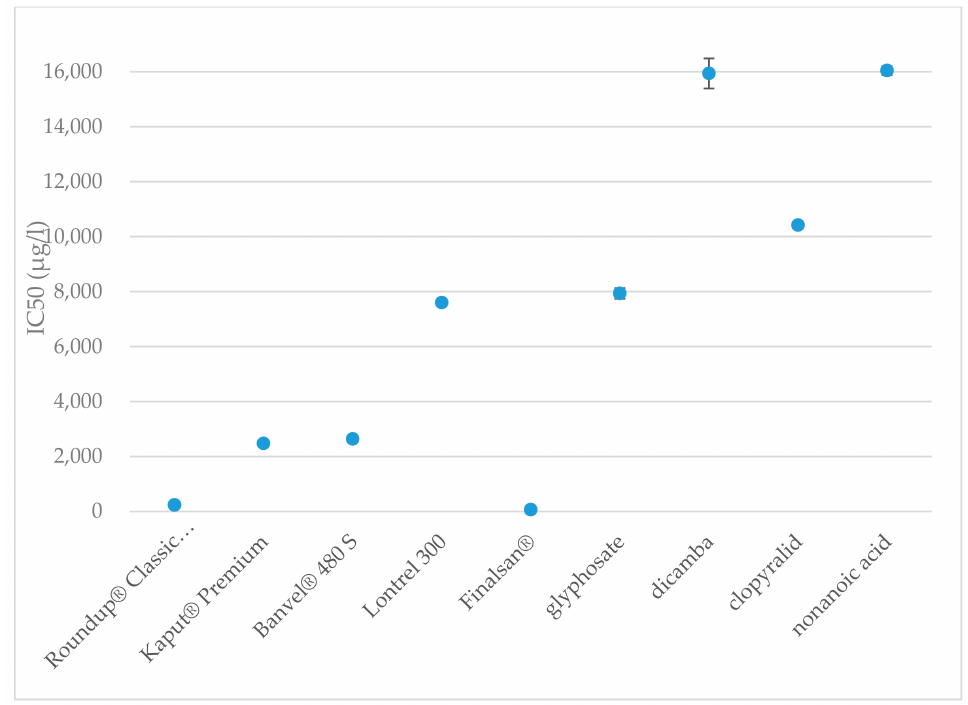
Figure 1. Toxicities of the herbicides and active substances after 15 min of exposure to A. fischeri . The data are expressed as the mean IC 50 value ± their respective standard